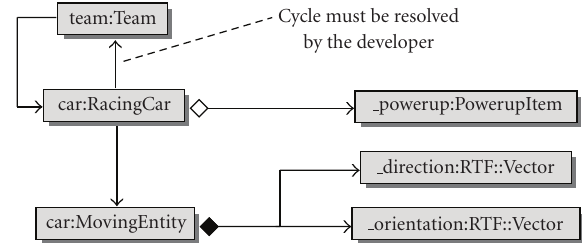
Figure 7: Example of an object graph supported by the generic serialization mechanism of